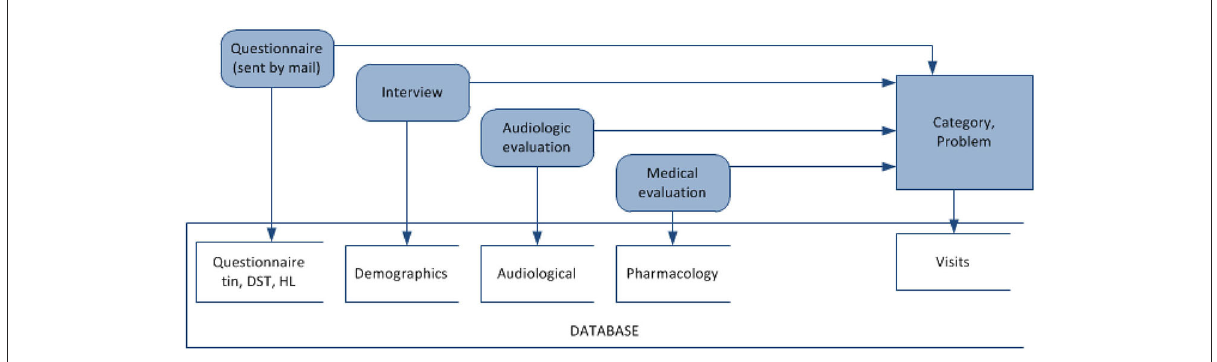
FIGURE3 Mining associations between questionnaire and interview answers, audiology variables, medications, and category of a hearing problem for decision support in diagnosis in